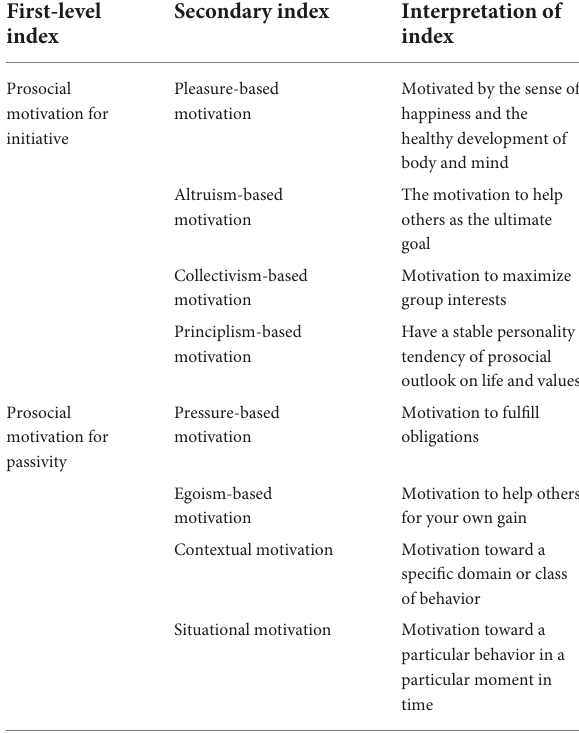
TABLE 1 Index system of prosocial